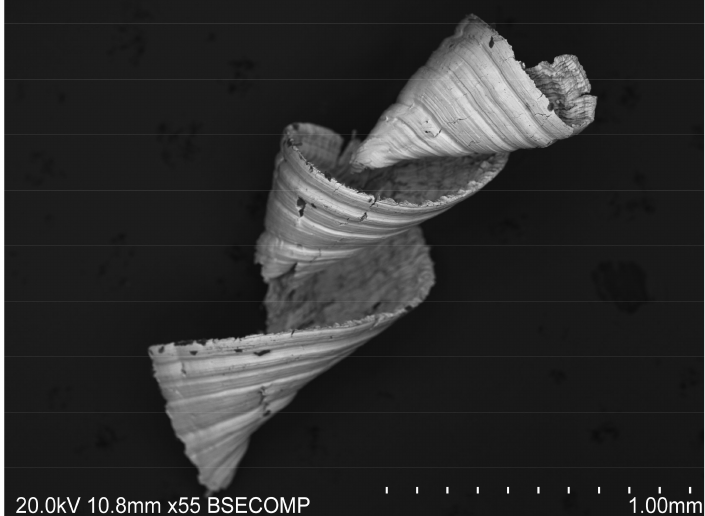
Figure 2. Sample extracted by drilling (S1).